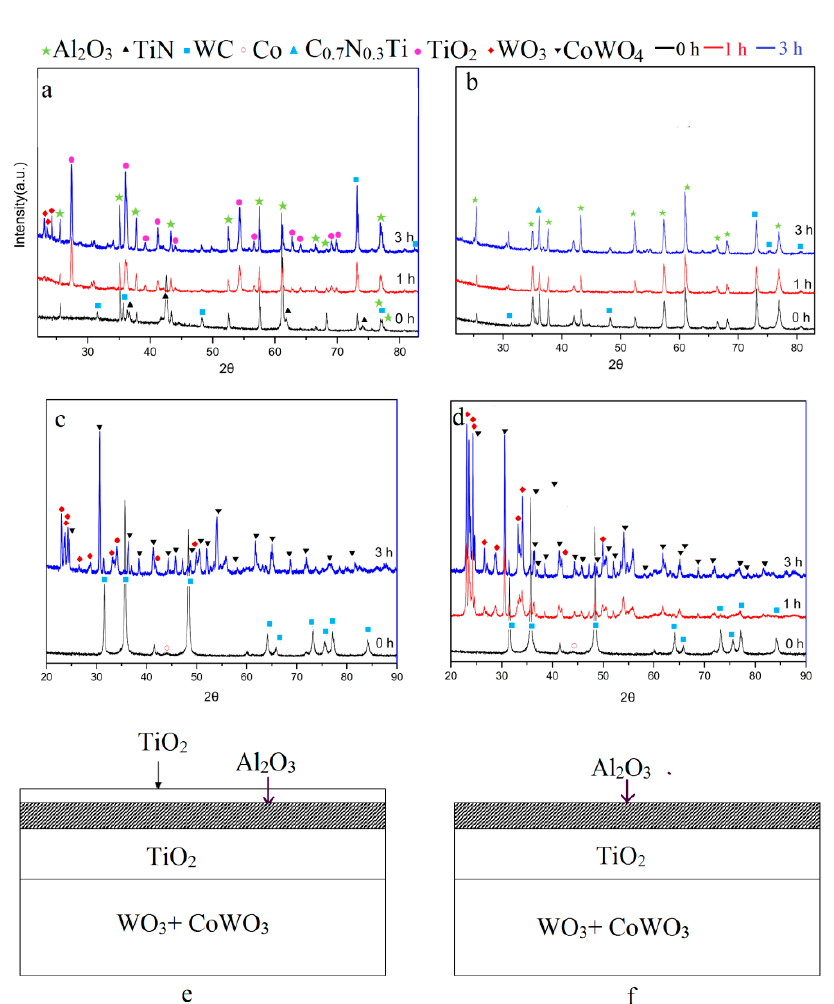
Figure 6. Chemical phases. XRD pattern of fragments oxidized for different oxidation time ( a ) the outmost yellow coating in flanks, ( b ) black coating in front faces, ( c ) substrate, ( d ) the XRD pattern of the fully oxidized powders, schematic diagrams of fully oxidized fragments ( e ) coated with yellow TiCN/Al 2 O 3 /TiN layers, and ( f ) coated with black TiCN/Al 2 O 3 layers.